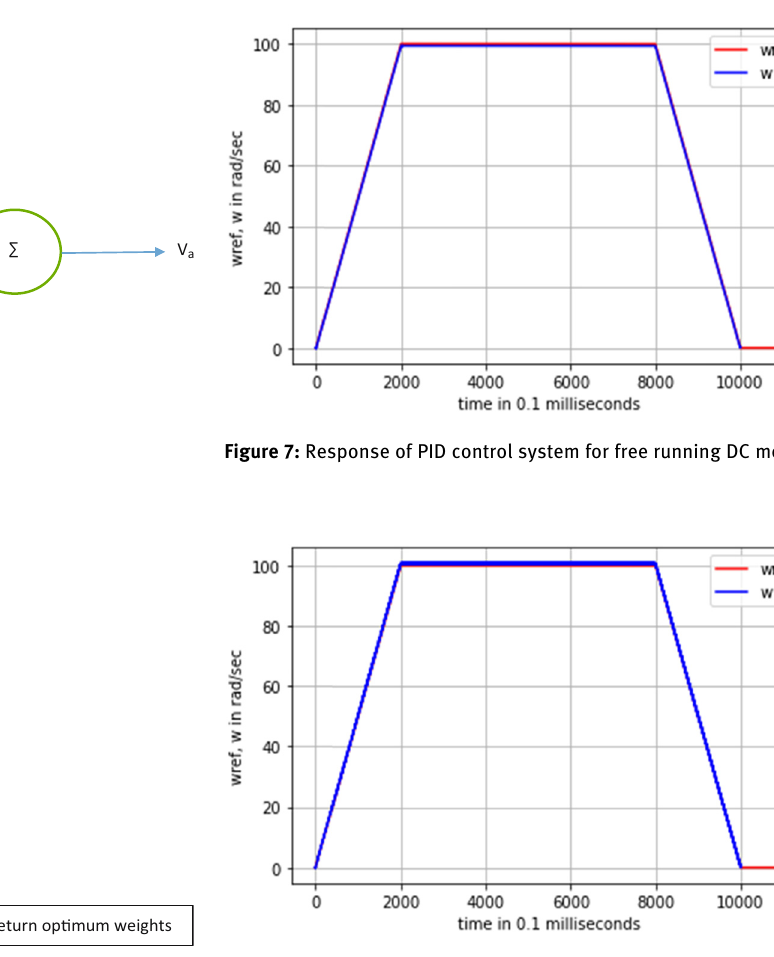
Figure 8: Response of LR control system for free running DC motor.